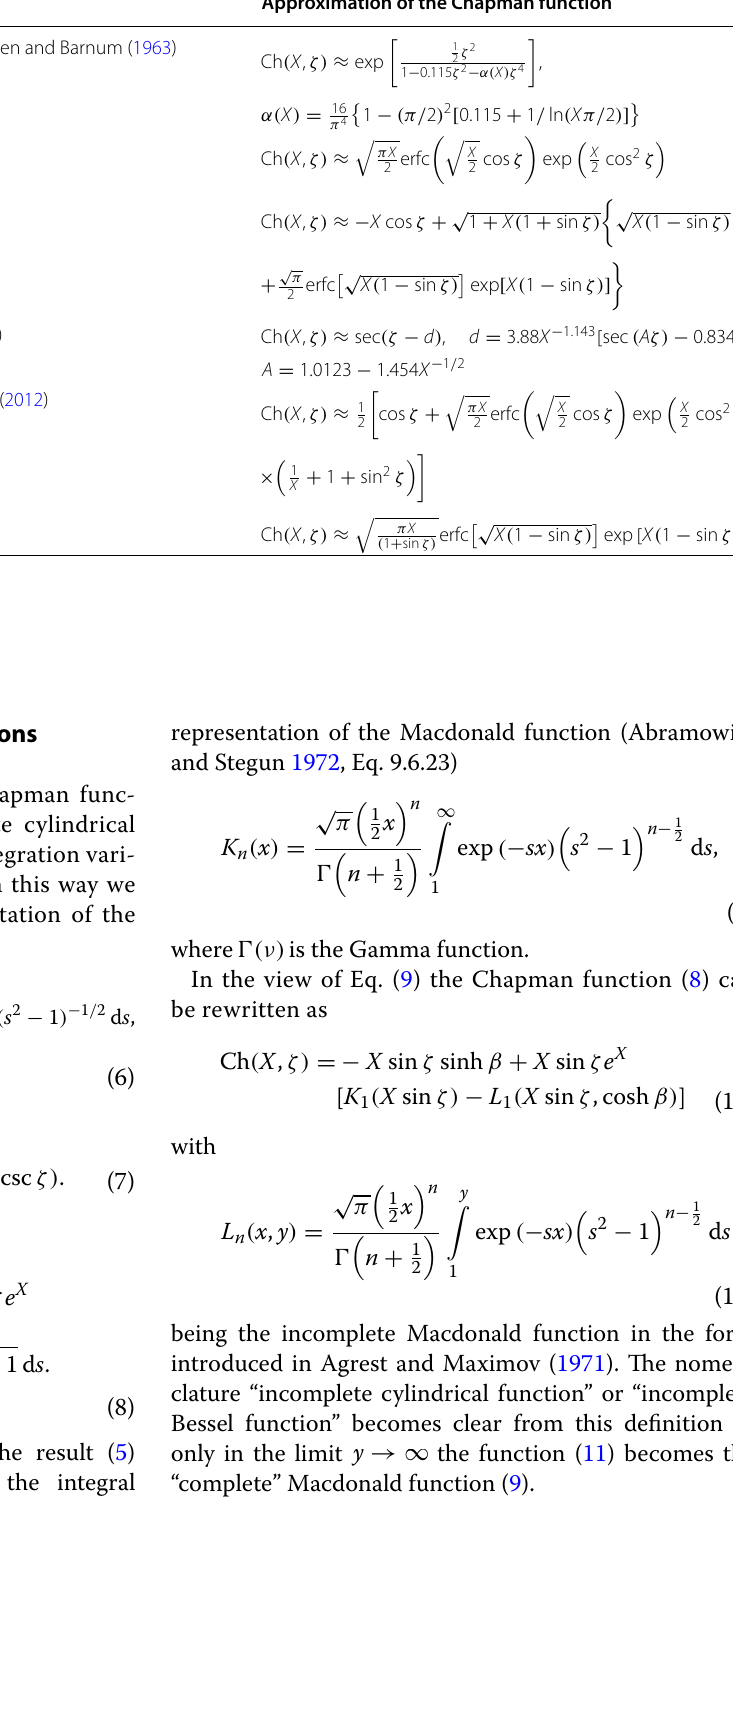
Table 1 Analytical approximations of the Chapman function (in chronological order). The solar zenith angle ζ is given in radian units Index Reference Approximation of the Chapman